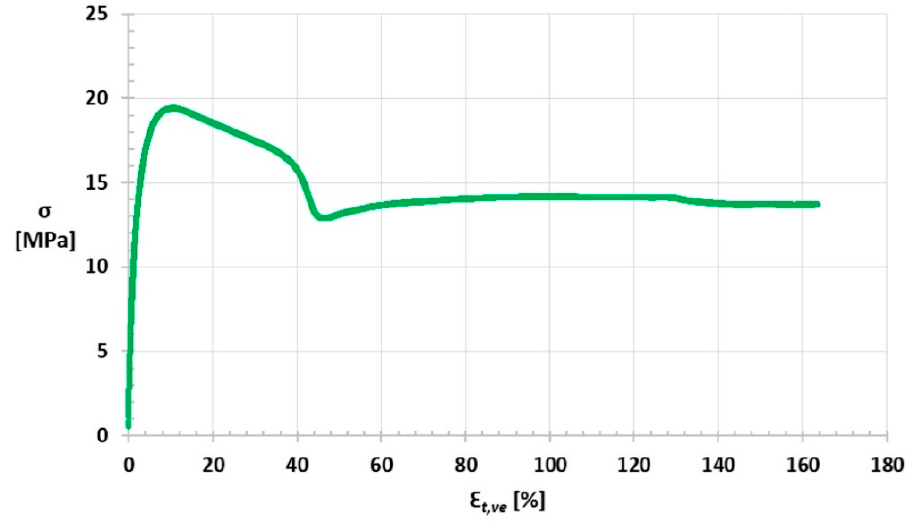
Figure 22. Stress σ relation to ε l strain graph (points to determine the tensile modulus E t are selected).